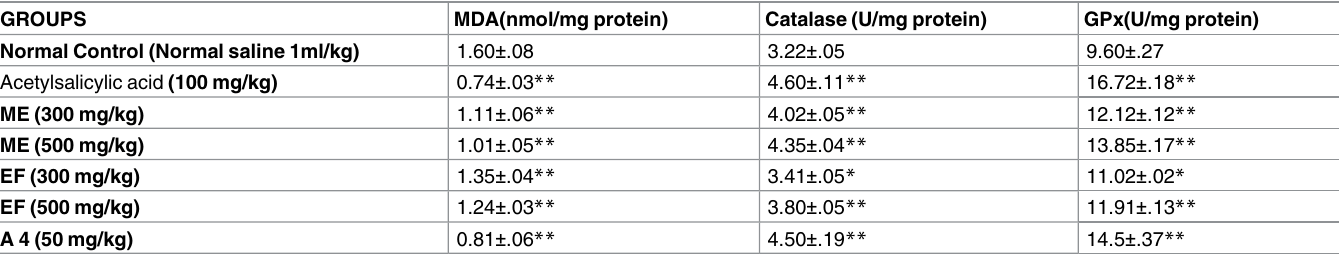
Table 3. Effects of M . philippensis on MDA, CAT and GPx activities.